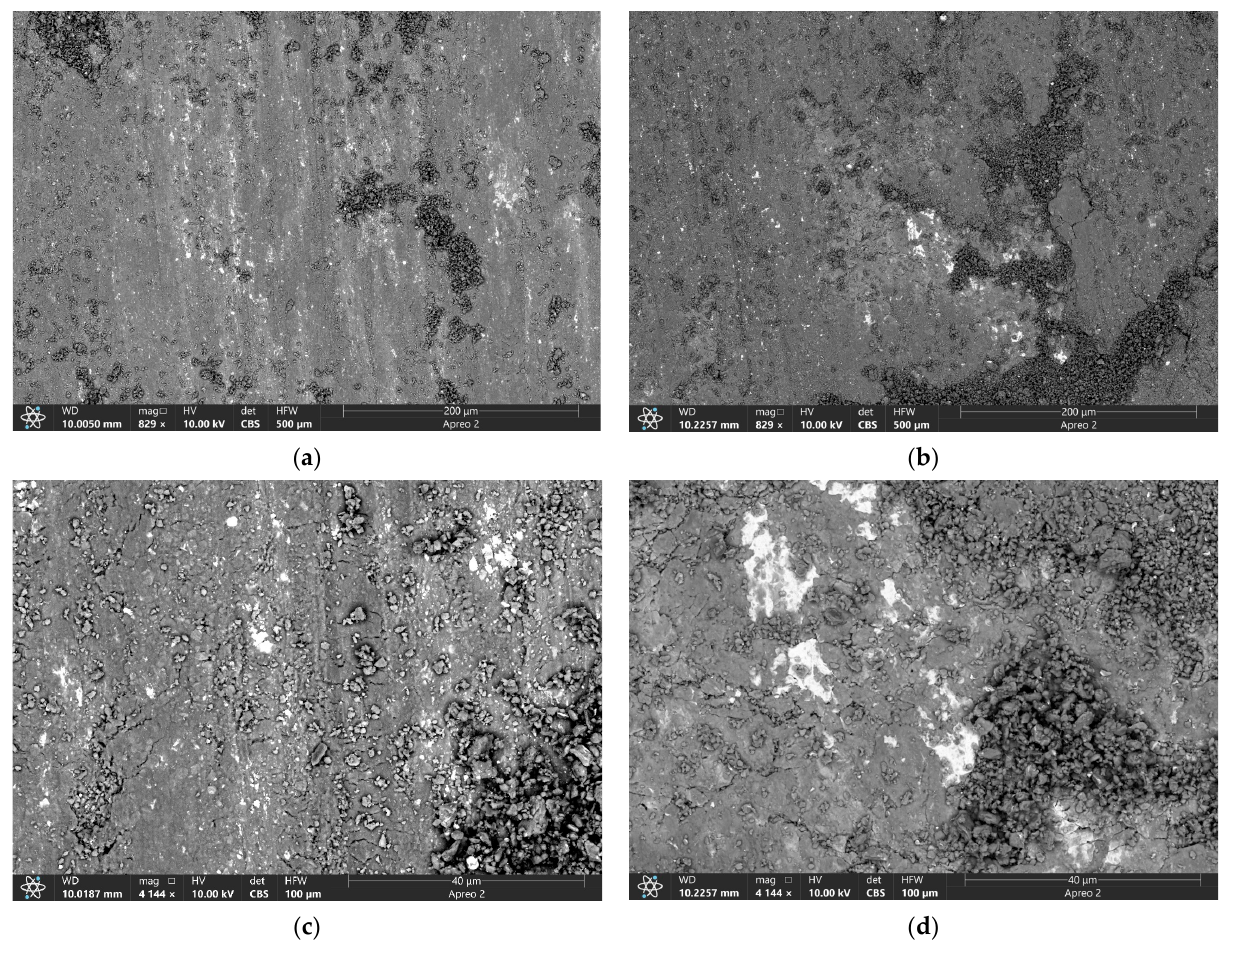
Figure 22. SEM BSE worn surface images of FSP-ed RPPs/AA5056 composite after 4 ( a , c ) and 8 ( b , d ) passes. Table 4. Chemical composition (EDS) of the worn surfaces of FSP-ed RPPs/AA5056 composites after 4 and 8 passes (Figure